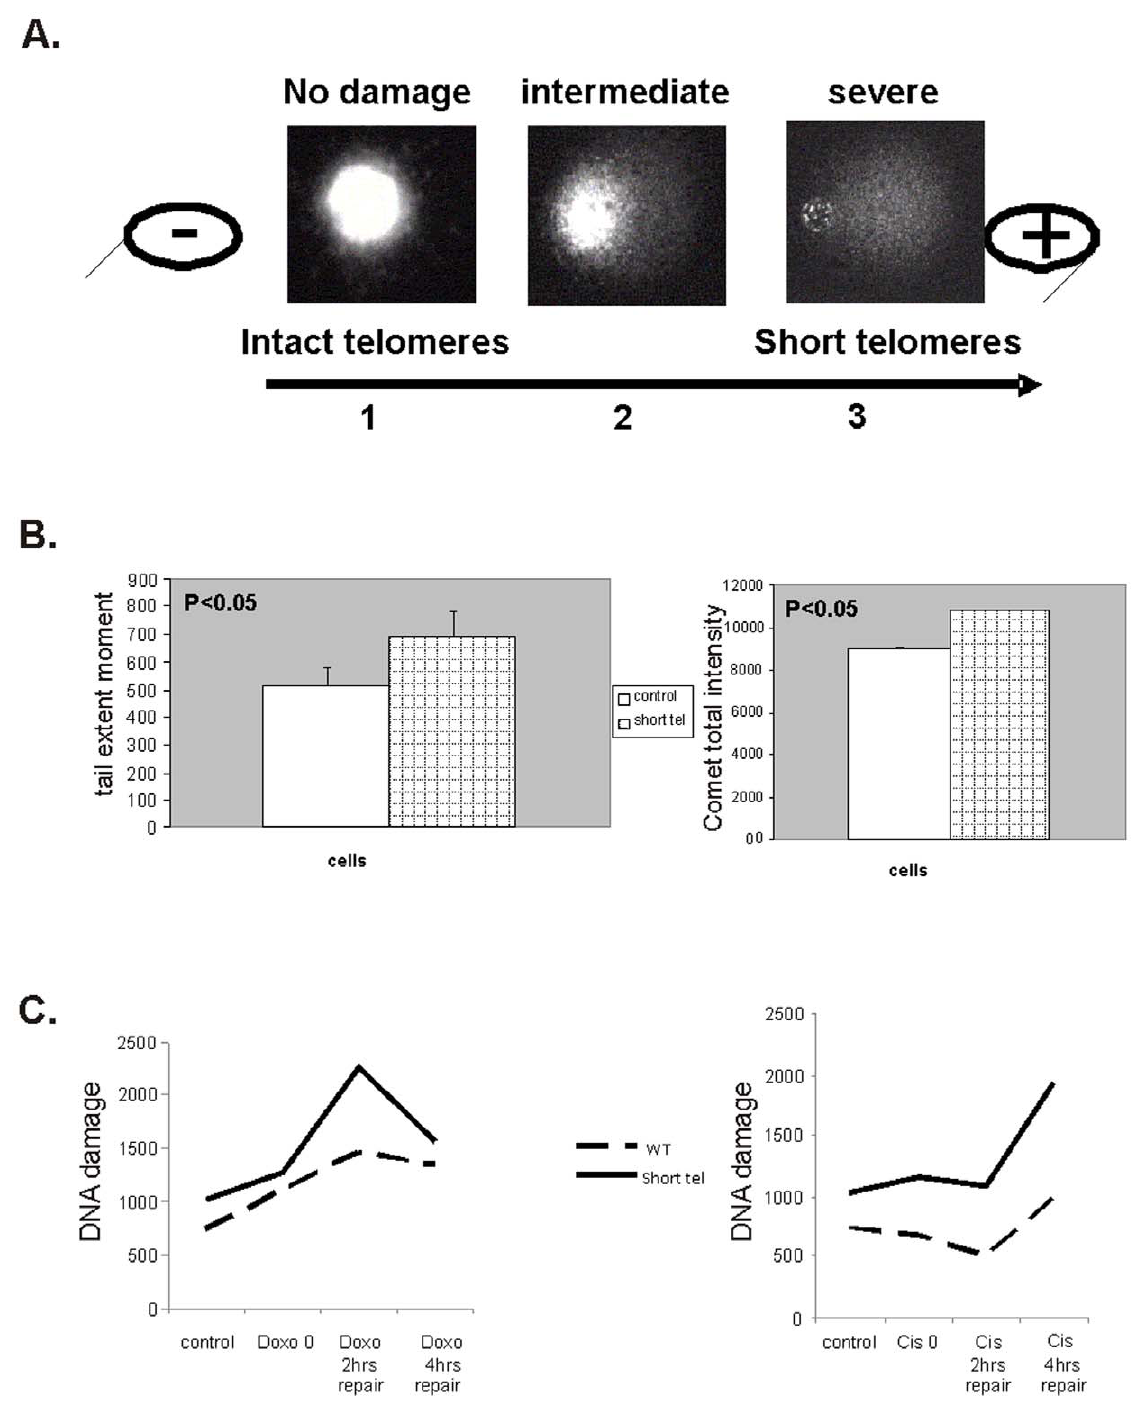
Figure 4. DNA damage status and repair ability of cells with shortened telomeres- the Comet assay. a. The principle of the comet assay. Cells nuclei were exposed to electrophoresis and stained with ethidium bromide. Broken DNA migrates out of the nuclei and forms the comet. Three degrees of DNA damage are shown: control nuclei with intact DNA (representing DNA damage in cells with intact telomeres, # 1), intermediate state in cells with partially broken DNA (representing cells with mild telomere shortening, # 2) and cells with shortened telomeres harboring damaged broken DNA (representing cells with shortened telomeres, # 3). b. Quantitation of the extent of the DNA damage status of cells with shortened telomeres, performed by screening 50 images per sample in quadruples. On the left- Tail extent moment parameter, on the right- total comet intensities. c. Quantitation of the extent of the ability of the cells to repair DNA damage applied by doxorubicin (right panel) or cisplatinum (left panel) 2 and 4 hours post drug induced damage. The assay was performed by screening 50 images per sample in quadruples. The DNA damage status was determined by calculating the tail extent moment.